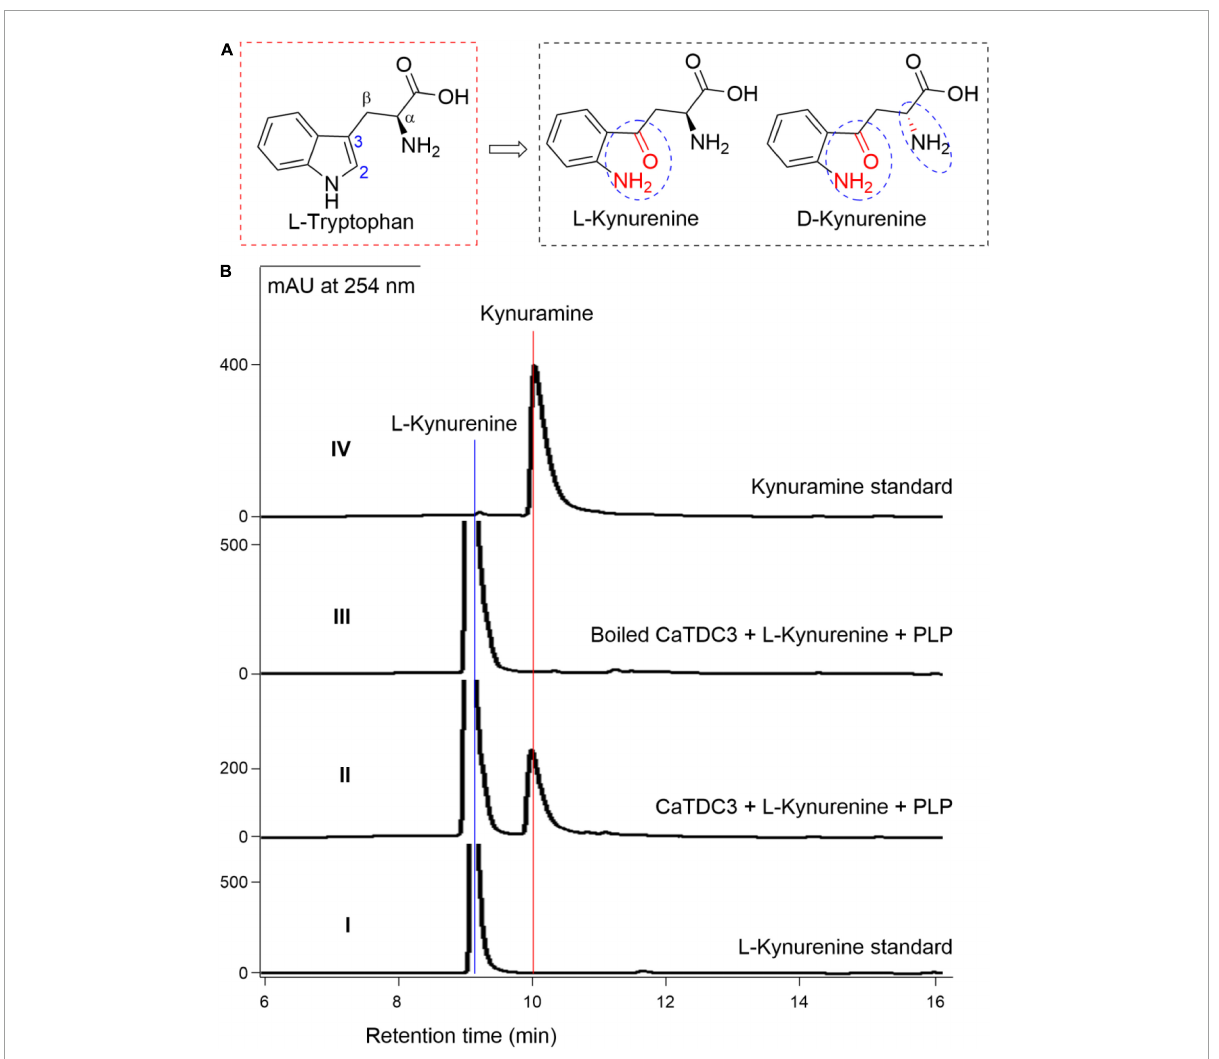
FIGURE11 CaTDC3-catalyzed decarboxylation toward L-kynurenine. The chemical structure similarity of L-tryptophan and kynurenines tested in the present work (A) . (B) HPLC-DAD analyses the standard L-kynurenine (panel I), the enzymatic reaction mixture with CaTDC3 (panel II), and boiled CaTDC3 (panel III) as catalyst, respectively, and the standard kynuramine (panel IV).